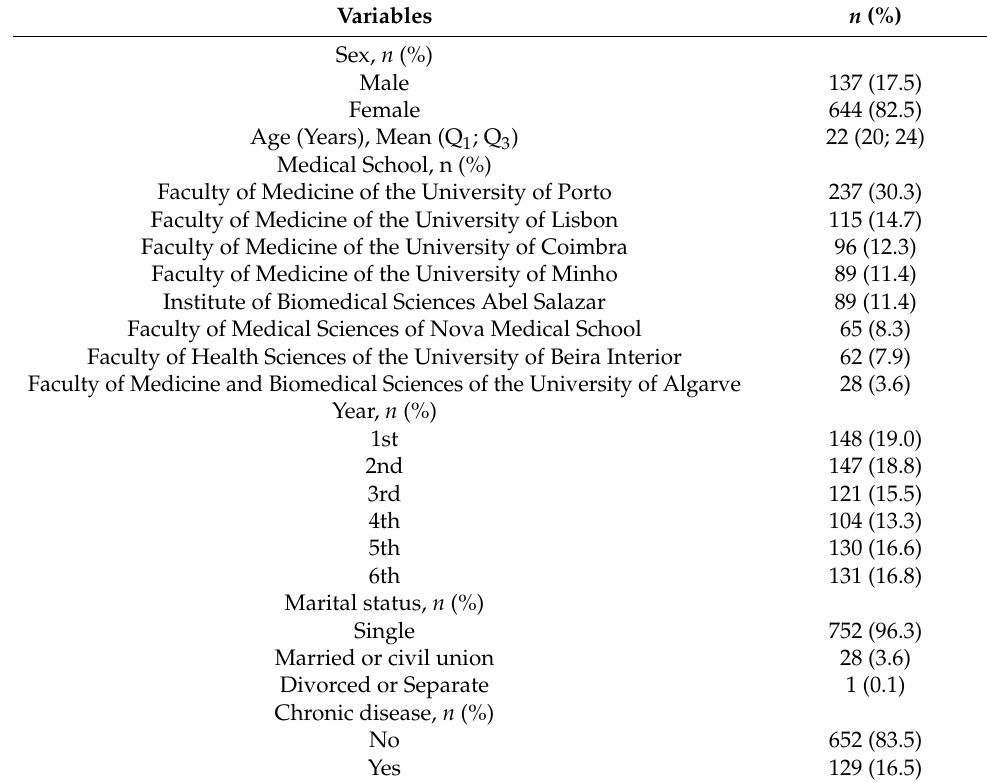
Table 1. Distribution of sociodemographic variables ( n = 781).